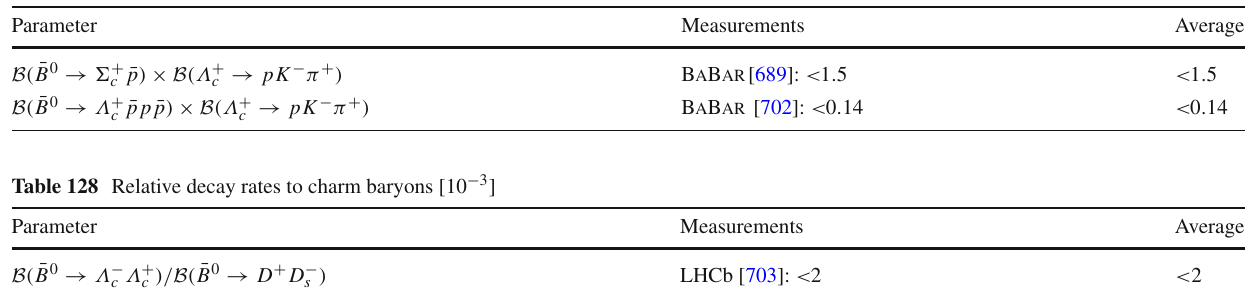
Table 127 Absolute decay rates to charm baryons III [ 10 − 6 ]